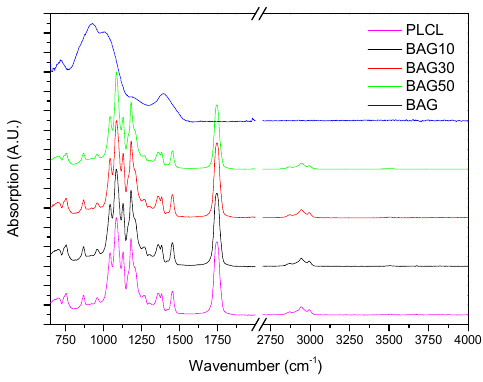
Figure 3. FTIR–ATR spectra of the investigated scaffolds (BAG10, BAG30 and BAG50) and of the borosilicate bioactive glass (for comparison).